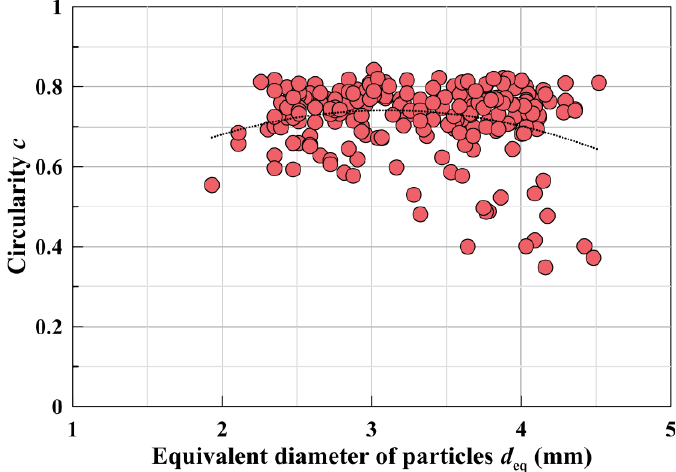
Figure 5. Relationship between circularity and equivalent